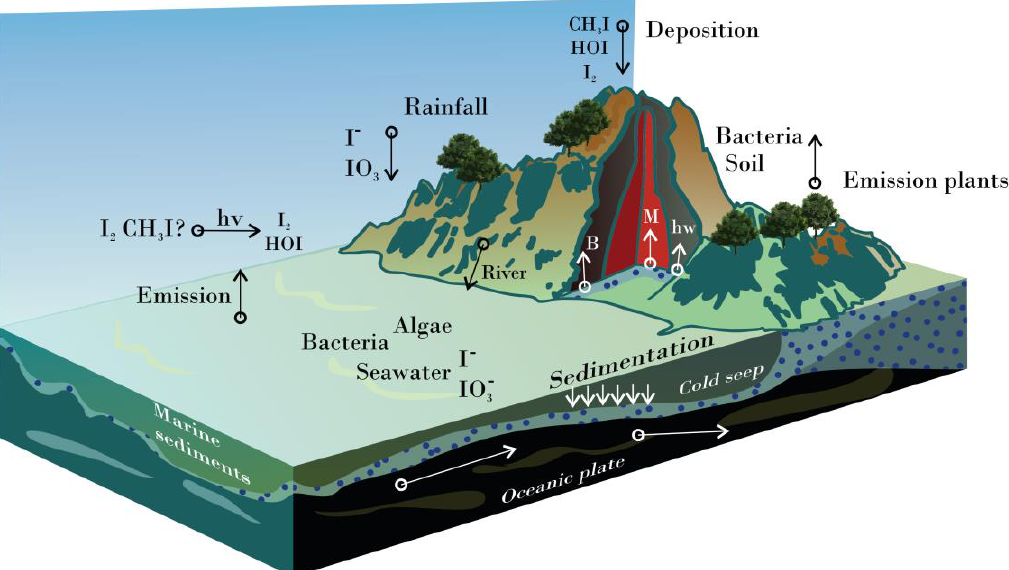
Figure 1. Iodine cycling in the environment. Adapted from [10], Royal Society of Chemistry, 2011. Abbreviations: B, brine; M, magma; hw , hydrothermal water; hv , energy of a photon (where h is Planck’s constant = 6.62607015 × 10 − 34 J·s, and v is the frequency of light = c·λ − 1 ).